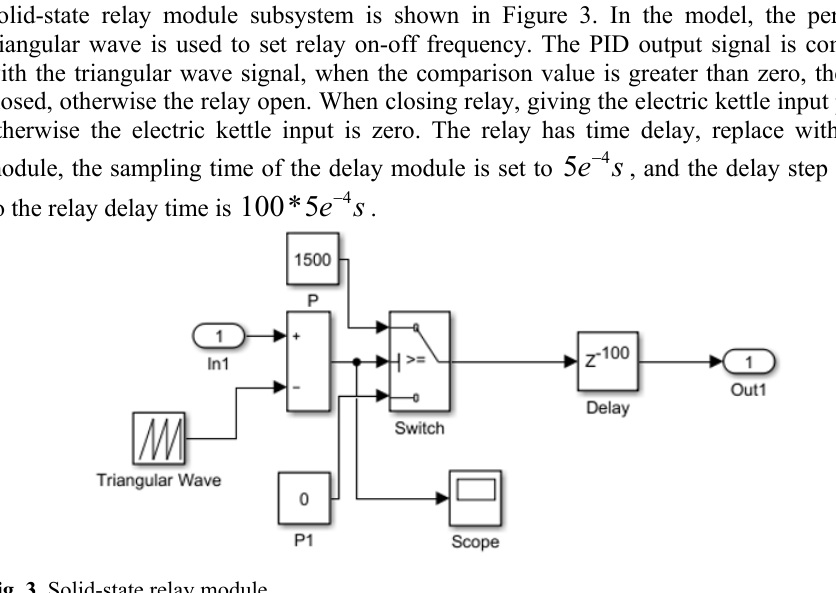
Fig. 3. Solid-state relay